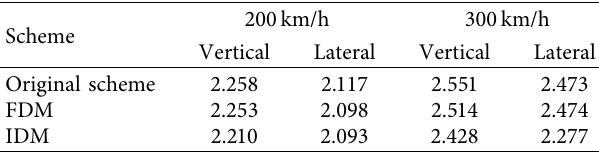
Table 5: Sperling index of car body center before and after optimization.